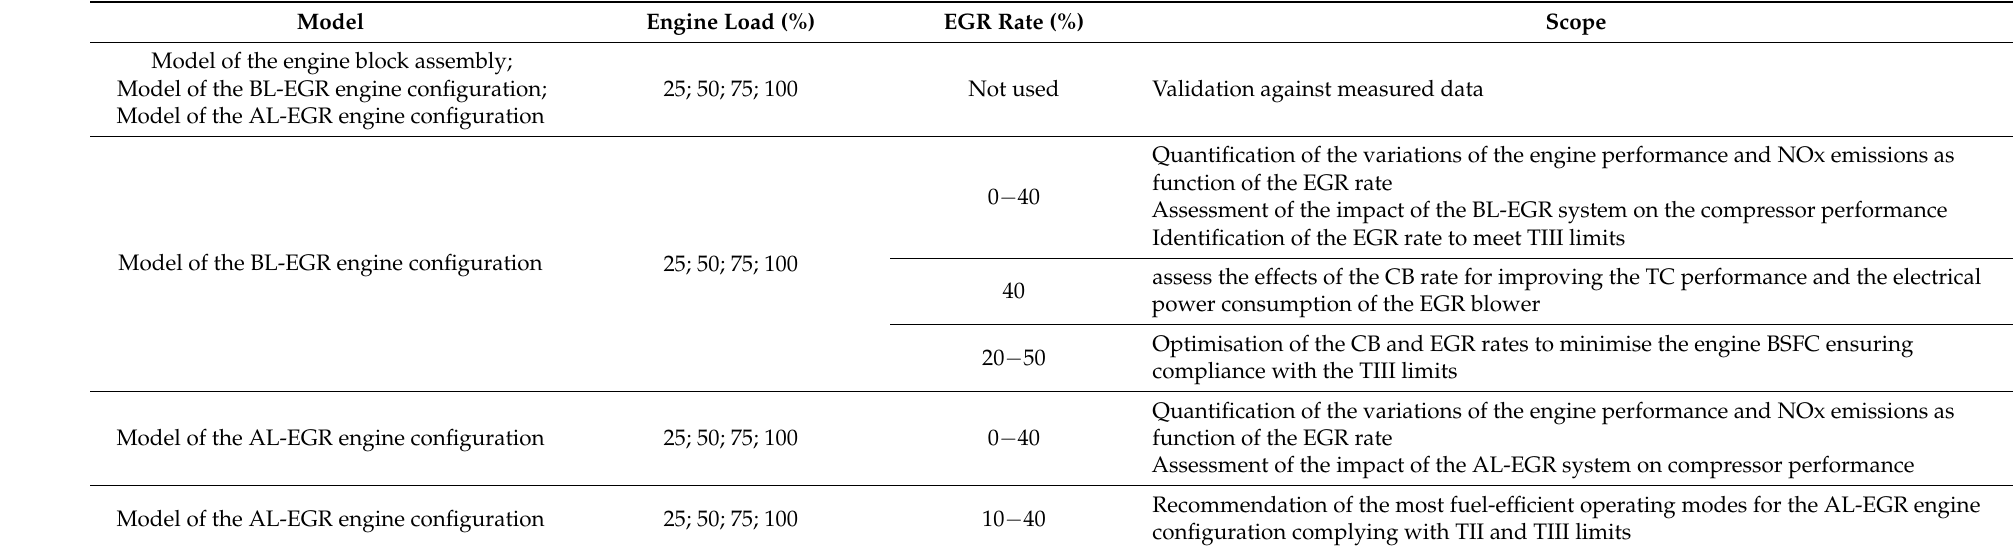
Table 4. Overview of the performed simulation